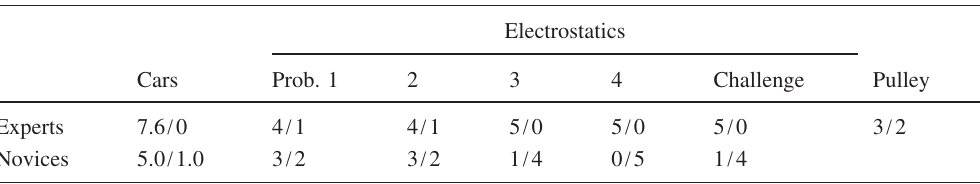
TABLE I. Student performance on the study problems. The Cars column shows the number of correct/ incorrect groups and subgroups made. The electrostatics columns for problem 1–4 and the challenge problem show the number of students answering correctly/incorrectly for those problems. The pulley column shows the number of experts answering the pulley problem correctly/incorrectly.